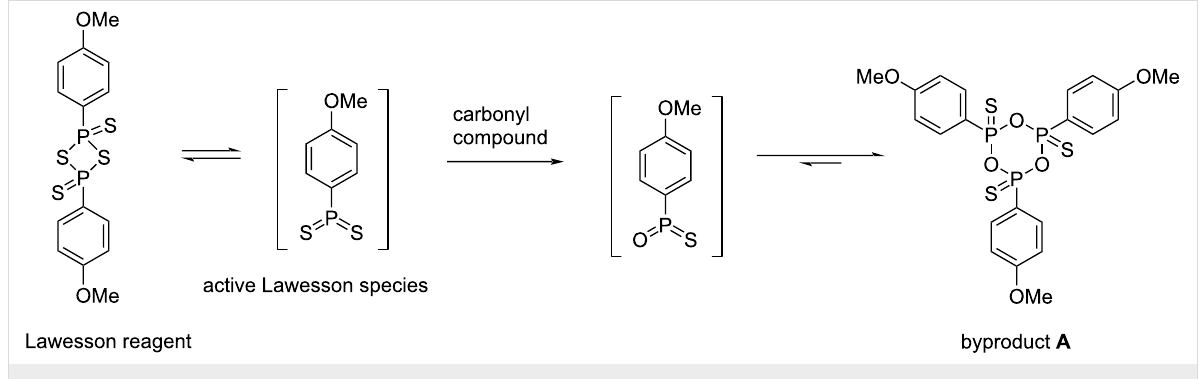
Figure 1: Generation of the six-membered byproduct A from thionation reactions using Lawesson’s reagent.